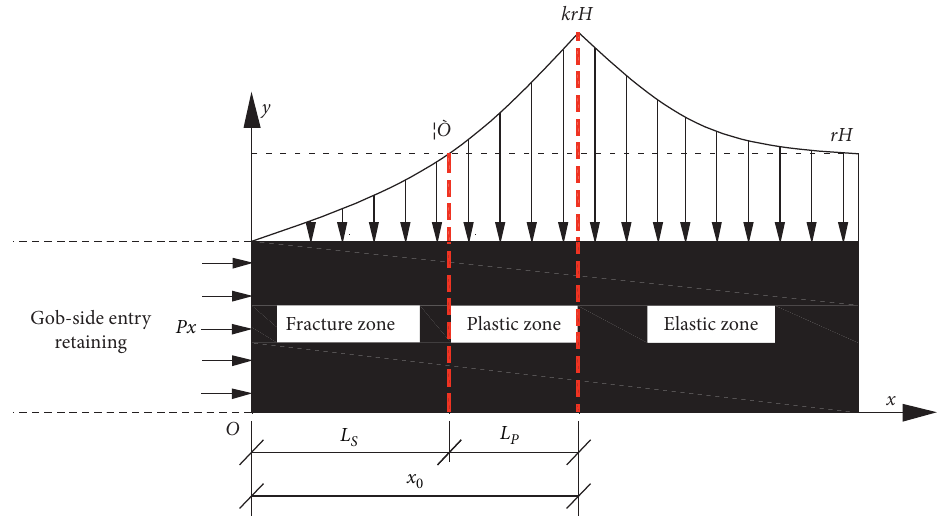
Figure 8: Analysis model of fracture zone and plastic zone in solid coal